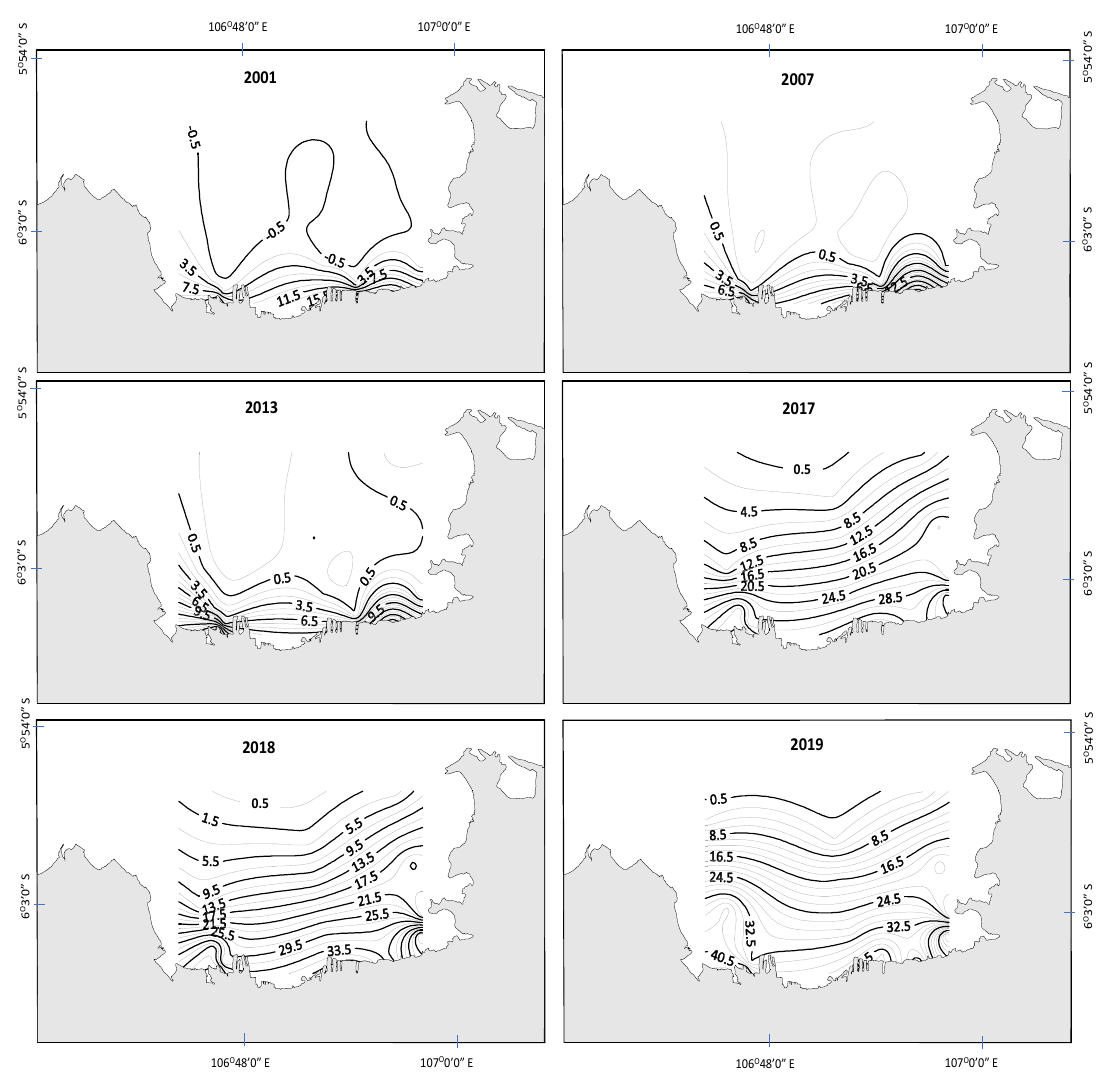
Figure 5. Spatial distribution of the mean phosphate concentration (µM) in Jakarta Bay.